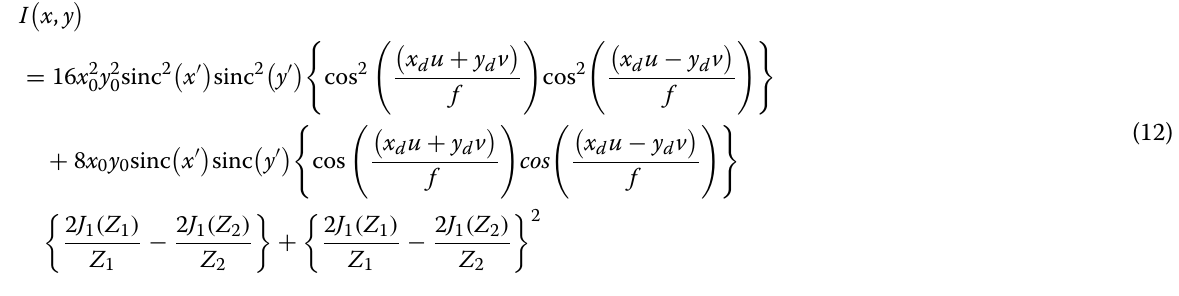
Fig. 2a–c, the strength of the legs of the diffraction pat- tern (PSF) is considered useful for imaging of extended objects as compared with the weak strength obtained in Fig. 2d. The magnified portions representing the PSF corre- sponding to the different models shown in the Fig. 3, is for the discrimination of the PSF structure. The image of the diffraction from the aperture shown the modulus square of the